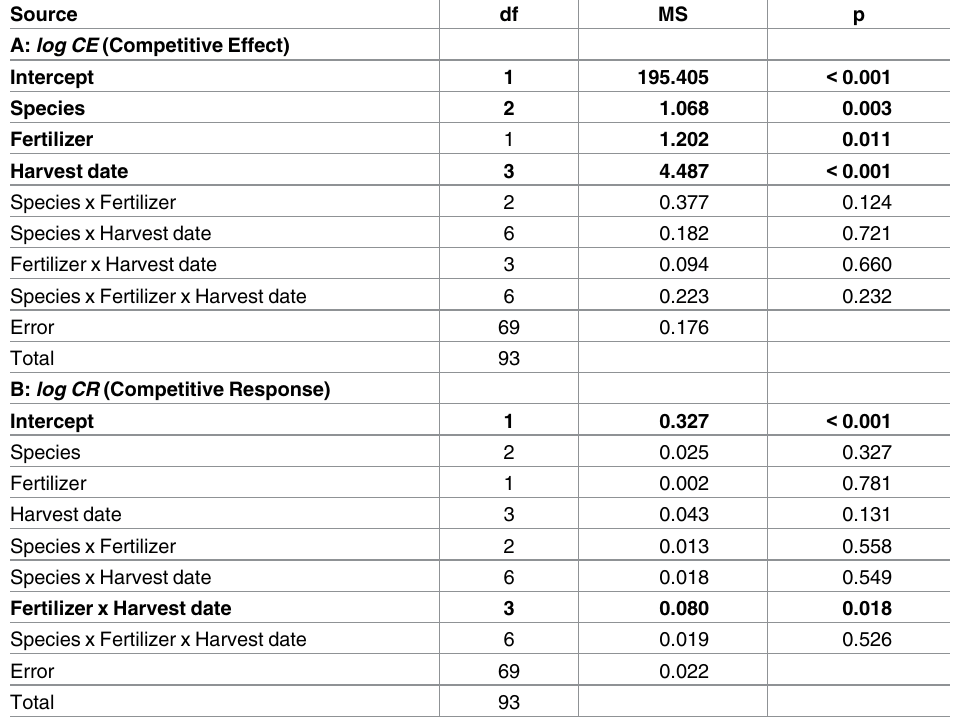
Table 1. Competitive effect and response of Johnsongrass on focal plants examined by ANOVA. Johnsongrass as focal plant was omitted from this analysisto focus on interspecific competition. Significant effects are highlighted in